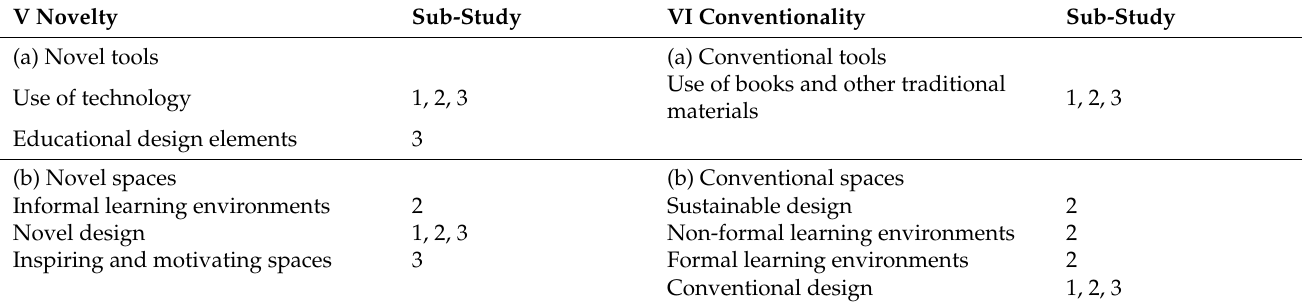
Table 4. Novelty- and conventionality-related characteristics confirmed or emerged in sub-studies. Sub-Study Sub-Study